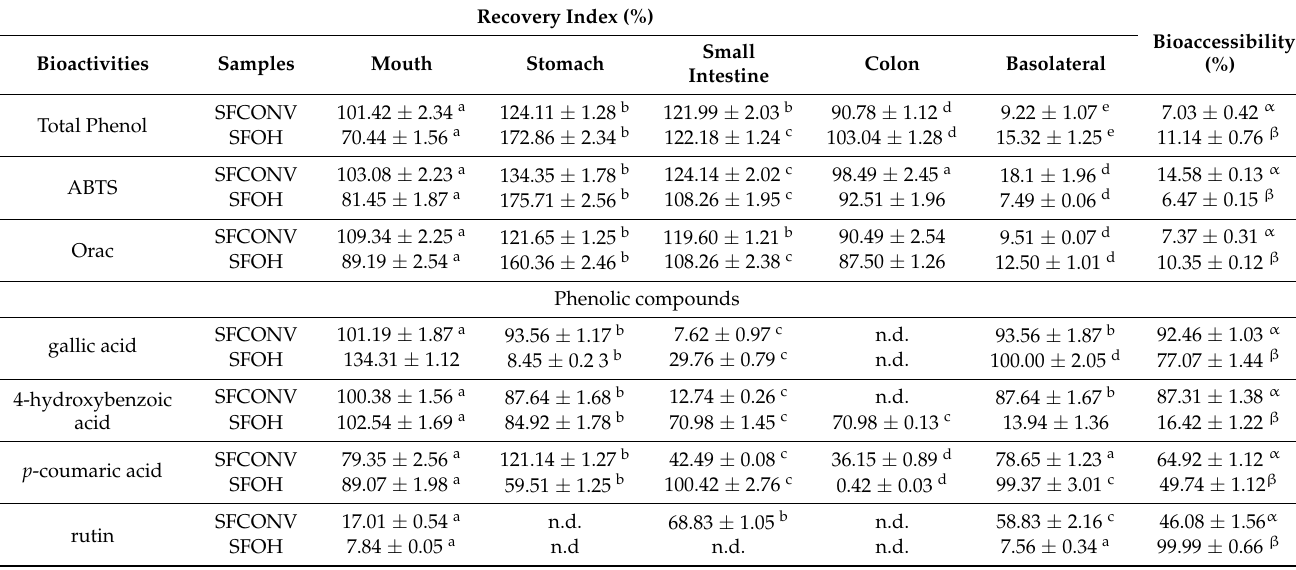
Recovery index and bioaccessibility %; n.d., not determined. Results are the means of three determinations ± standard deviation. Different letters in the same row are significantly different ( p < 0.05), the Greek alphabet symbol means significant differences between methods used in the same column ( p < 0.05), as determined by ANOVA ( p <